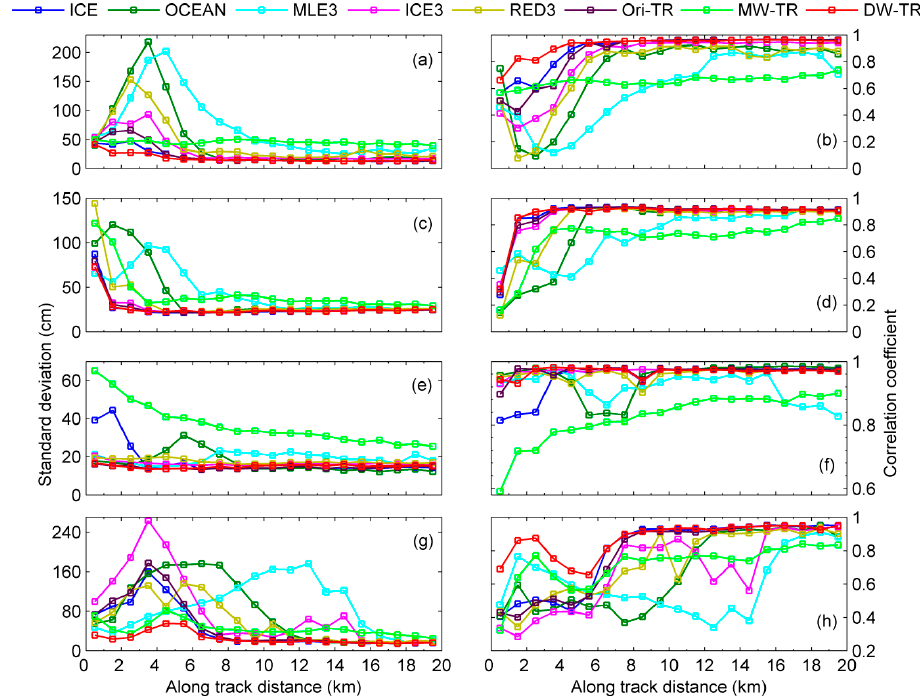
Figure 6. Along-track standard deviations (left column) and correlation coefficients (right column) between various retracked SSHs and tide gauge within 20 km offshore. Each node is computed using the SSHs within the corresponding zone of 1 km in width. Study region is arranged in row: ( a , b ) Los Angeles, ( c , d ) Cape May, ( e , f ) Funchal, ( g , h ) Ko Lak.